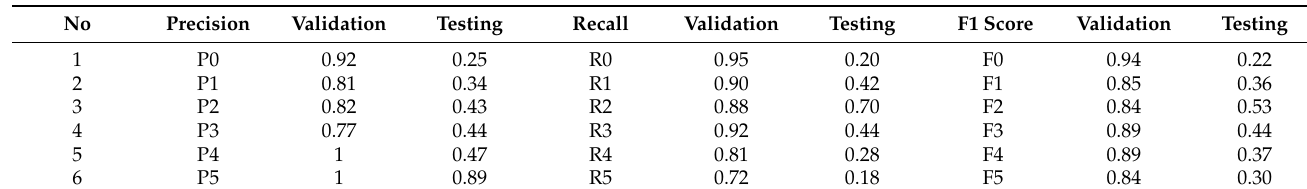
Table 8. VAE-CNN precision, recall and F1 Score for validation and testing phase for six-class classification.